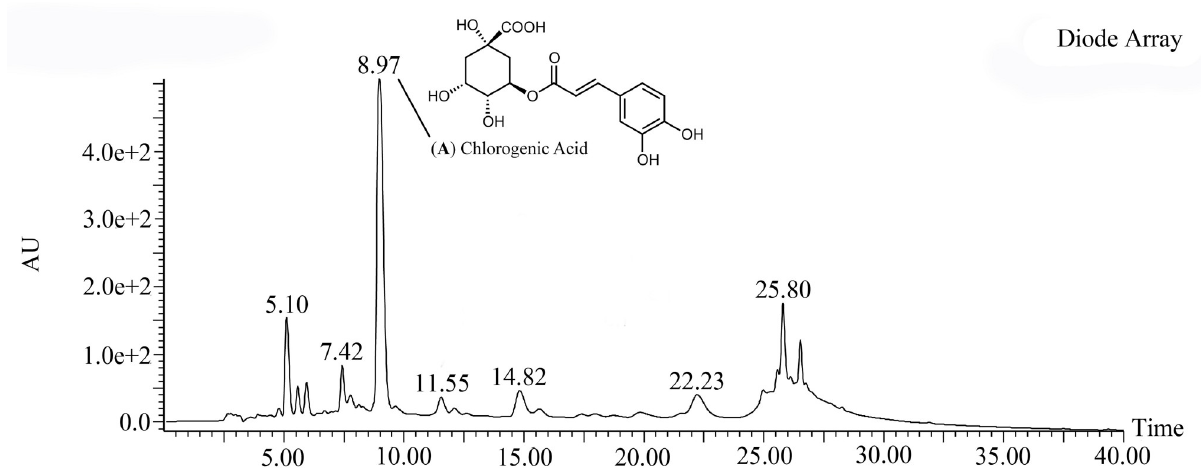
Fig 2. Chromatogram of C . officinarum AE. From the obtained chromatogram the major peak was identified as Chlorogenic Acid.